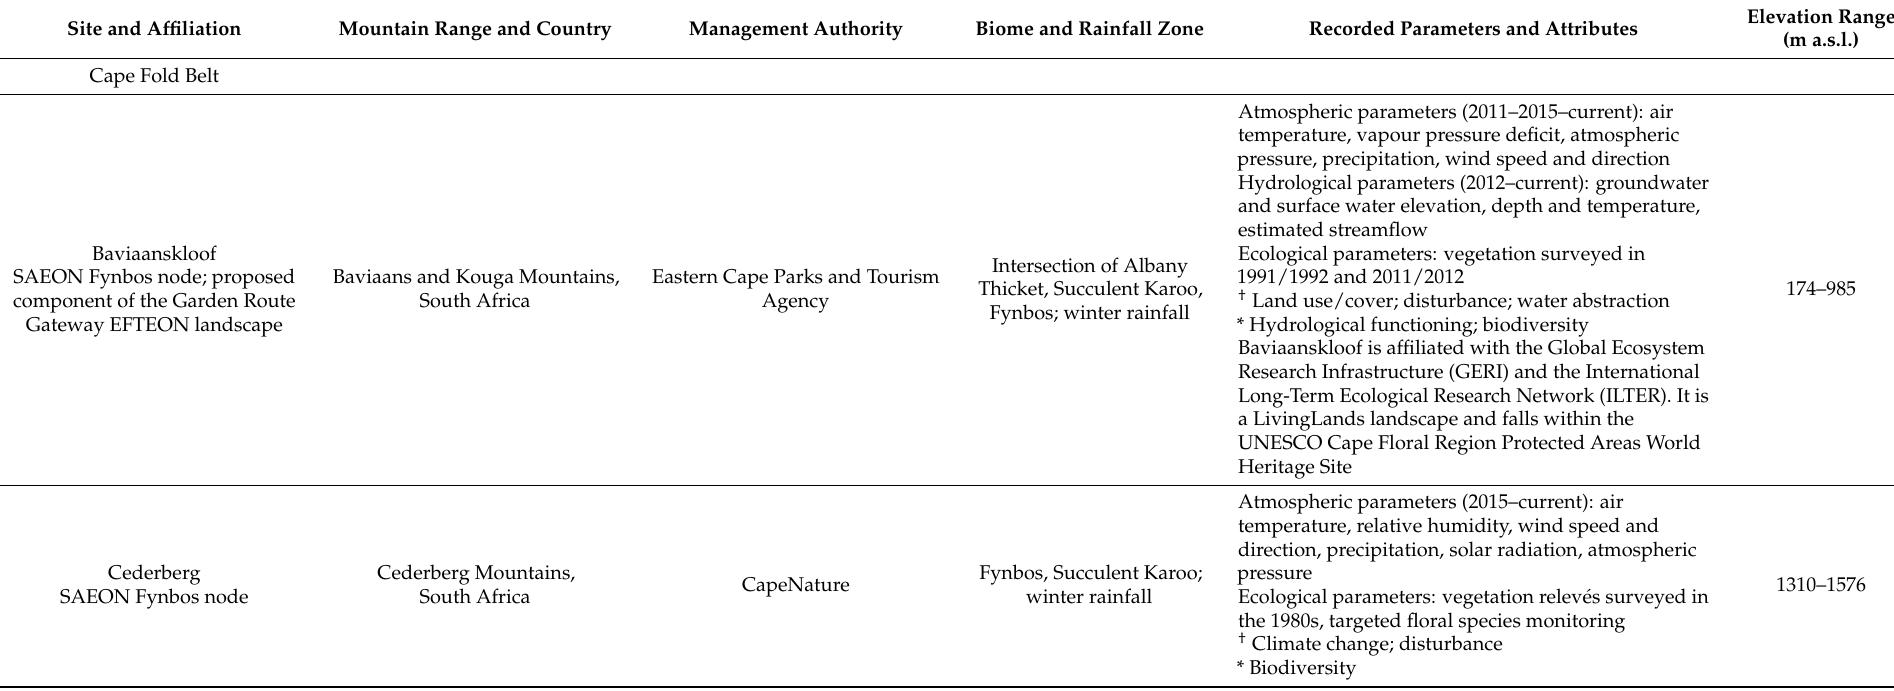
Table A1. Summary of the mountain observatories in Southern Africa. Atmospheric and hydrological research is included in the broader LTER framework to showcase the full suite of parameters measured long-term. Key environmental change drivers † and response variables * are indicated for each observatory [164]. Date ranges start with the earliest instrumentation/infrastructure for at least one of the data parameters listed. Mid-range dates are shown where the South African Environmental Observation Network (SAEON) resurrected earlier data collection. Data collection and recording frequency vary with changes in stations, instrumentation, or custodianship of the research platform. Elevation range at each observatory reflects the spread of data collection activities, not necessarily the topographic extremes (with the exception of the Mont-aux-Sources and Sani Pass